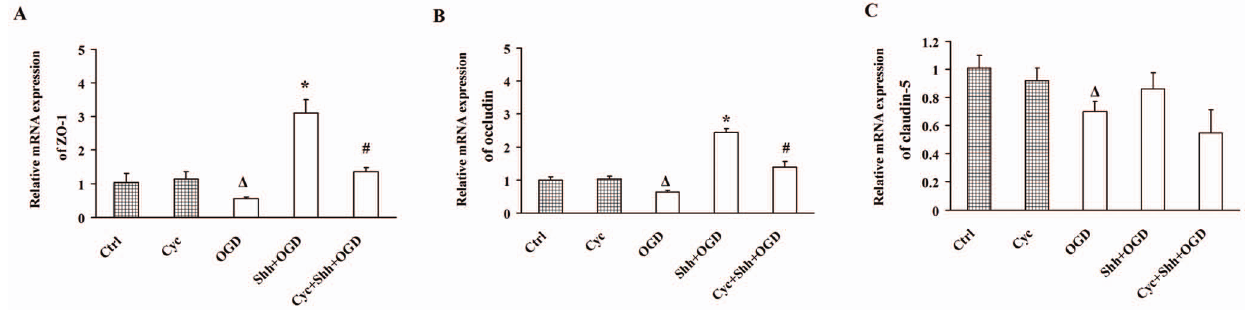
Figure 4. Shh Treatment Upregulates the Expression of ZO-1 and Occludin in BMECs under OGD. BMECs were pre-treated with PBS, Shh and/or cyclopamine (Cyc) for 30 min, and then subjected to the OGD for 4 h. (A-C) The mRNA levels of ZO-1 (A), occludin (B) and claudin-5 (C) were determined by real-time RT-PCR. Ctrl: cells were pre-treated with PBS and then subjected to normal oxygen condition. Cyc: cells were pre-treated with Cyc and then subjected to normal oxygen condition. OGD: cells were pre-treated with PBS and then subjected to OGD. Shh + OGD: cells were pre- treated with Shh and then subjected to OGD. Cyc + Shh + OGD: cells were pre-treated with Shh plus Cyc and then subjected to OGD. D P , 0.01 vs. the Ctrl group, * P , 0.01 vs. the OGD group, # P , 0.01 vs. the Shh group. Each experiment was repeated three times (n=6, each